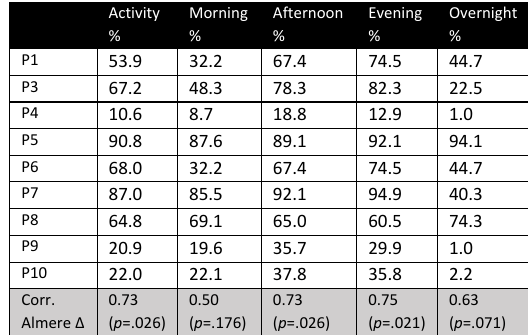
and without pets. Scores range from 1 to 5.